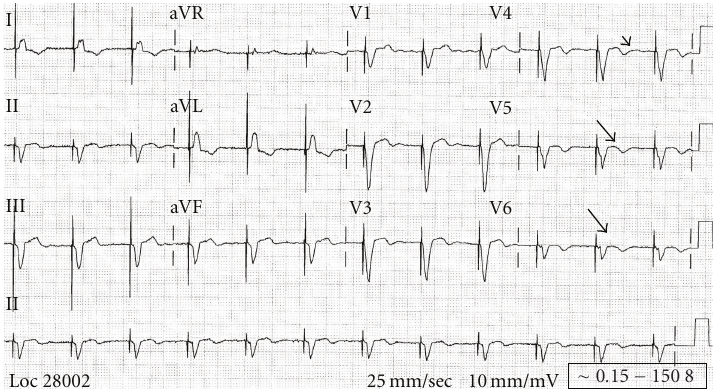
Figure 1: ECG at presentation: ventricular-paced rhythm at the rate of 70, prolonged corrected QT interval (QTc) of 510 milliseconds (msec) and concordant T wave inversion in lateral precordial leads.